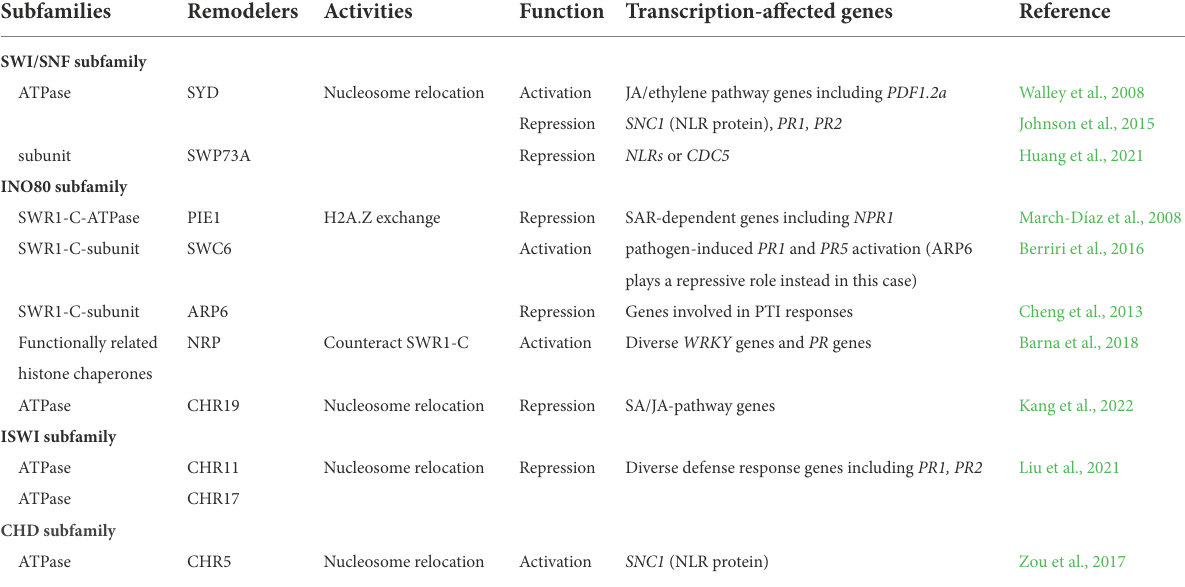
TABLE 3 Chromatin-remodeling factors implicated in plant response to